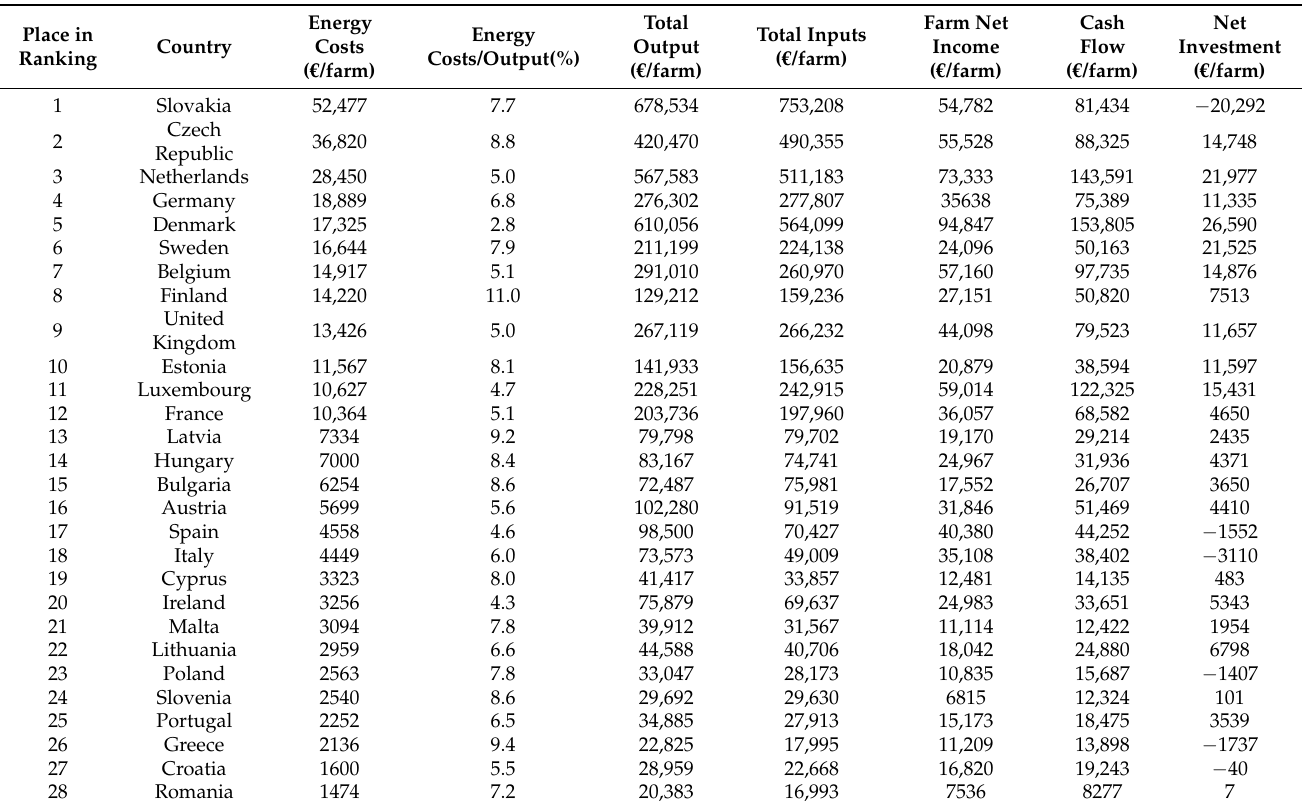
Table 2. Ranking of the European farms according to the energy cost and other financial information in